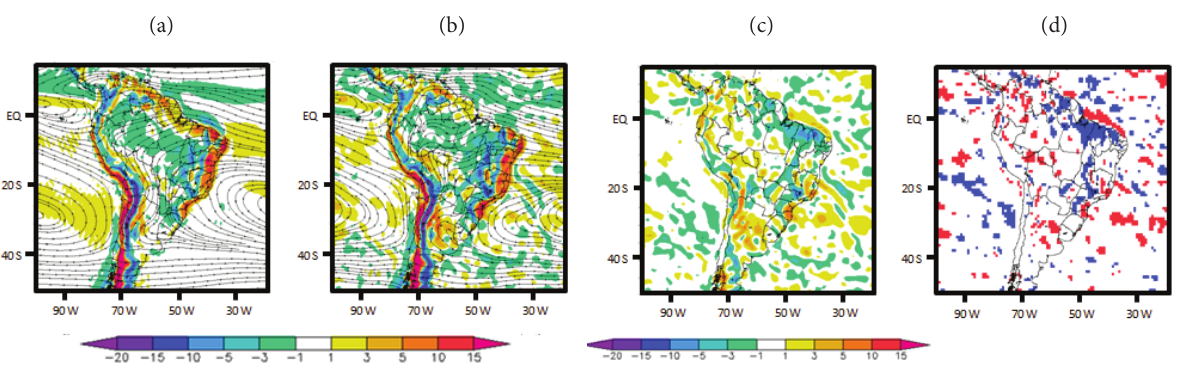
Figure 8. Atmospheric divergence at 850 hPa (10 –6 ·s –1 ) (a) for the dry quarter (SON) in the period 1979-2017, (b) for the 15 days with heavy precipitation and deep convection, and (c) the difference between them, i.e., “b” minus “a”. Data from the ERA- Interim reanalysis were used. (d) Differences are statistically significant at the 95% confidence level (Student’s t-test) over the shaded areas (blue: negative difference; red: positive). (a and b) Streamlines are